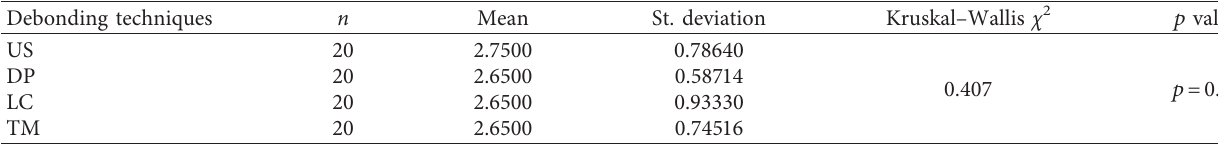
Table 2: Mean Enamel Surface Index (ESI) among different debonding techniques.